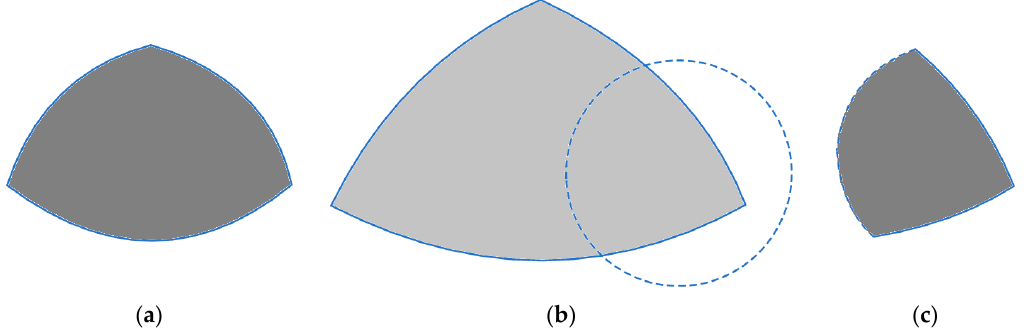
Figure 1. Computing the potential location area of the I -state: ( a ) LA of an initial information state; ( b ) expansion to account for the passage of time and intersection with range of the sensor node posting the detection message; ( c ) the resulting LA of the updated I -state [2].